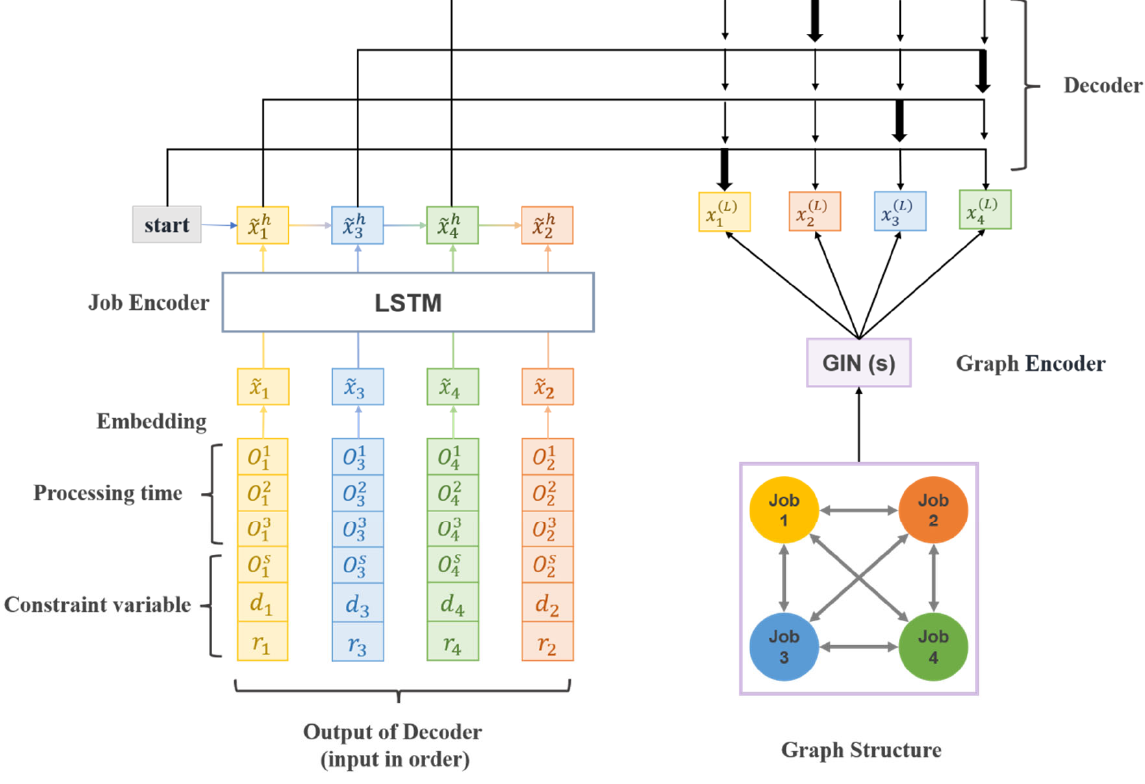
Figure 4. The proposed policy network structure (scheduling sequence: 1, 3, 4, 2).